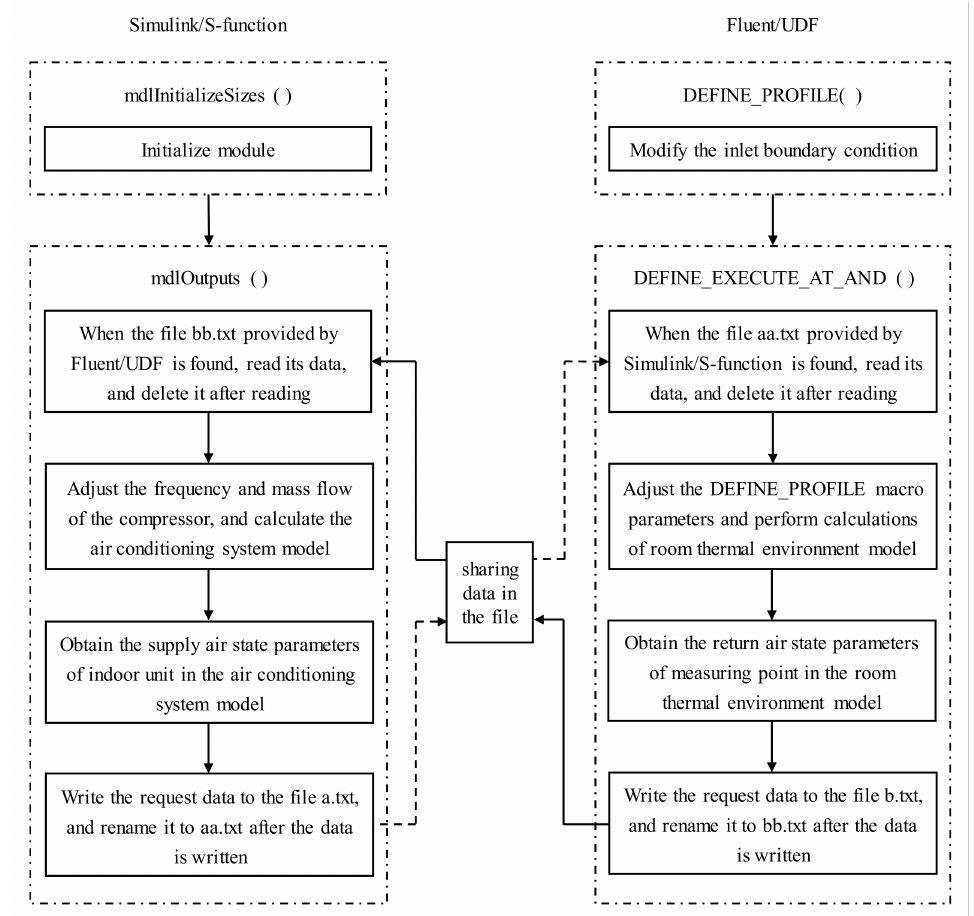
Figure 1. Workflow of collaborative